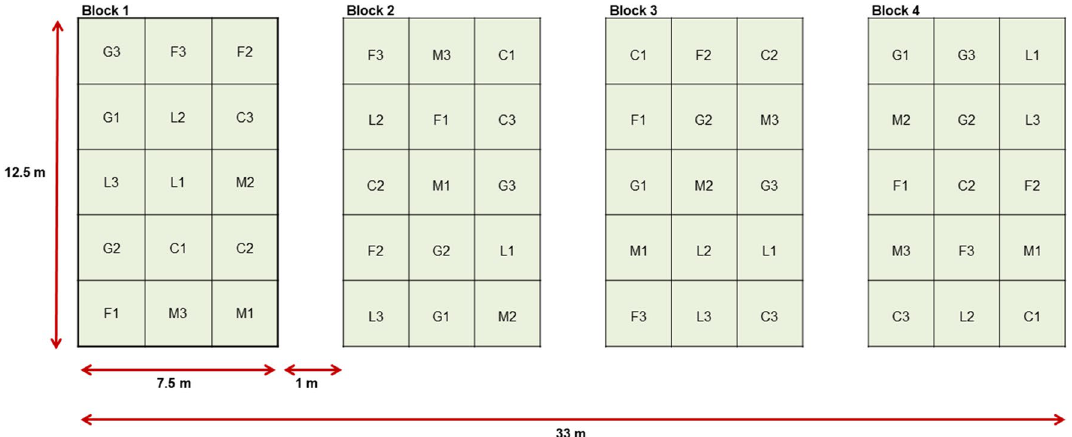
Figure 1. Experimental design based on sowing mixtures [grasses (G), grasses with legumes (L), seeds from the seminatural meadow (M), application of fresh hay (H), and control (C)] and mowing regimes [once (1), twice (2), and three times